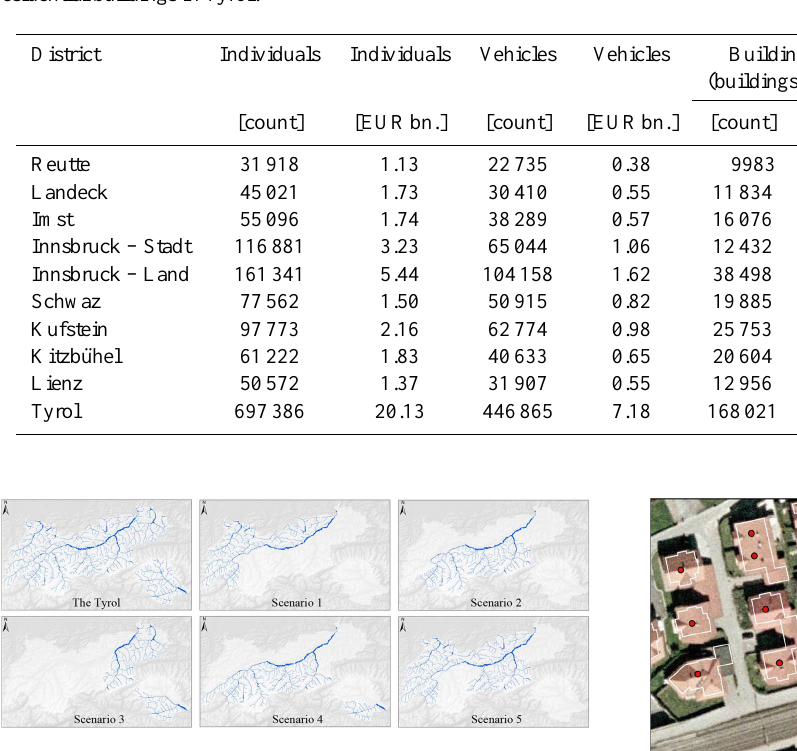
Fig. 6. Cartographic overview of the general flood hazard areas and the applied hazard scenarios in the study area Tyrol.